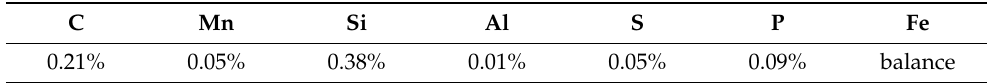
Table 7. Mild-steel chemical composition